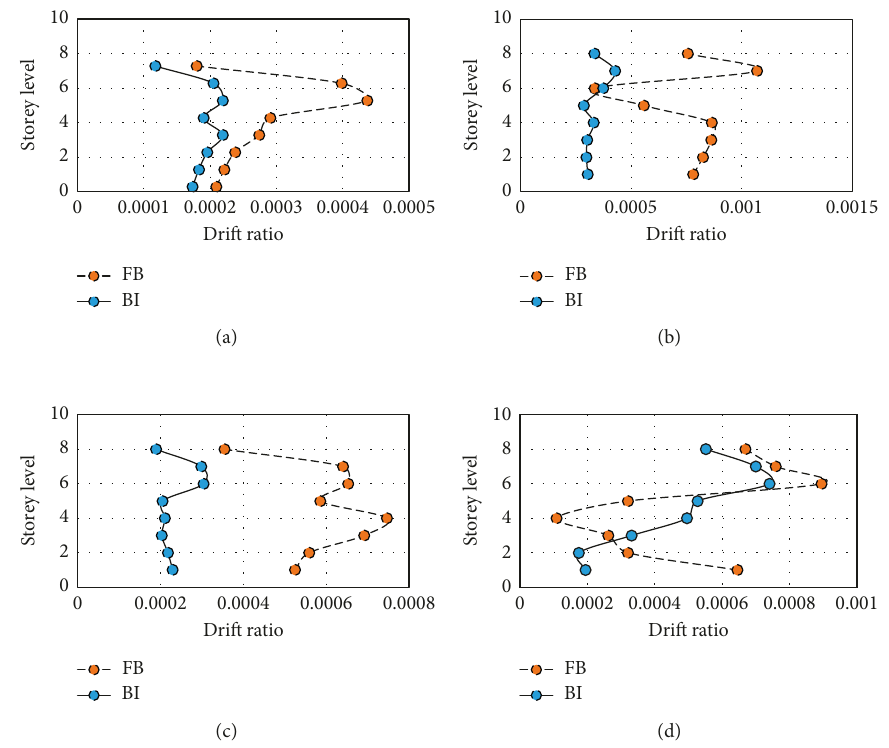
Figure 17: Storey drift for FFB and FBI buildings. (a) Cape. (b) LACC-N. (c) S-Monica. (d)